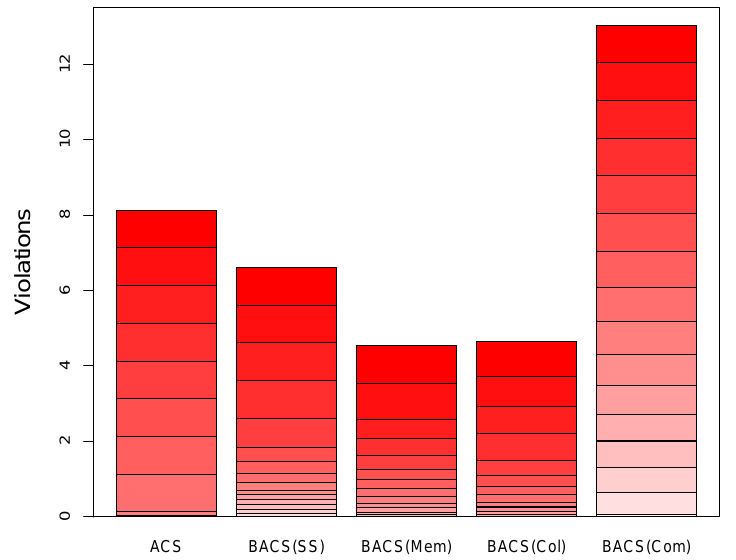
Figure 4. Feasibility violation of algorithms on different